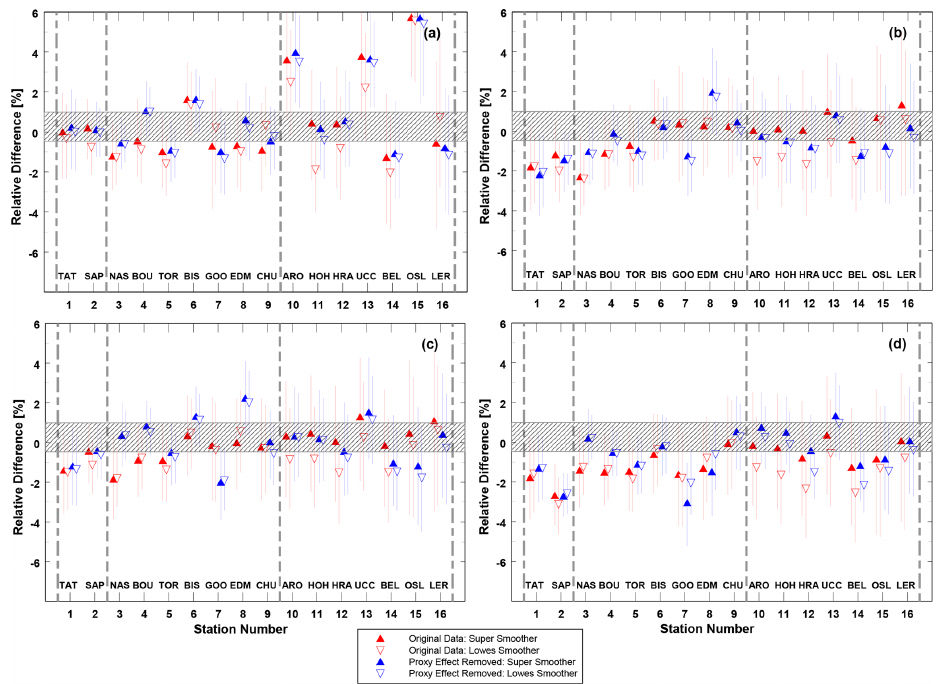
Figure A3. The same as Fig. A1 but for ORI 1 (1988 , 2020) based on the TCO 3 monthly means averaged over the cold sub-period of the year (October–next year March).